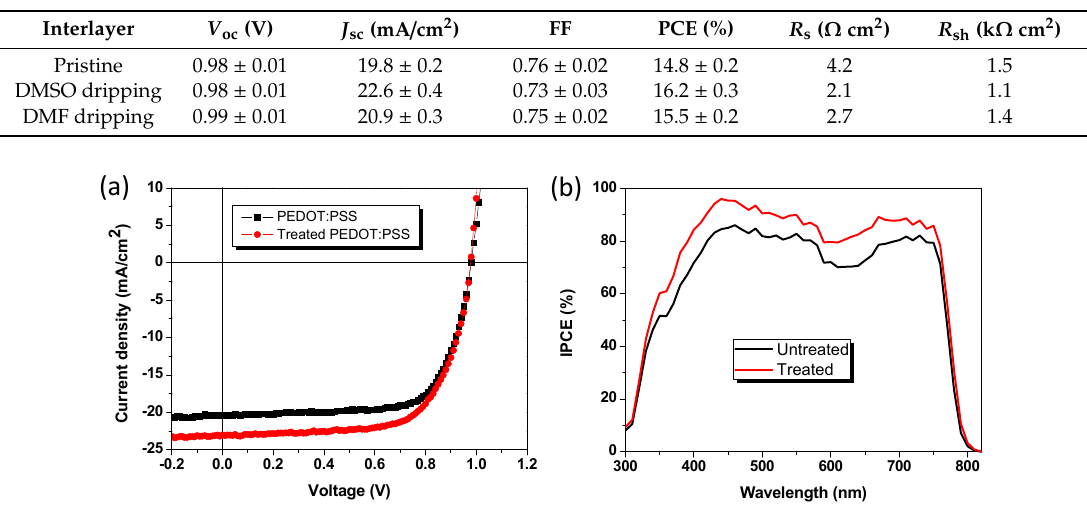
Figure 7. ( a ) J – V characteristics and ( b ) IPCE spectra of perovskite solar cells based on pristine and DMSO solvent washing treated PEDOT:PSS layers. Table 3. Average device parameters of twenty-four perovskite solar cells based on pristine and solvent washing treated PEDOT:PSS layers.